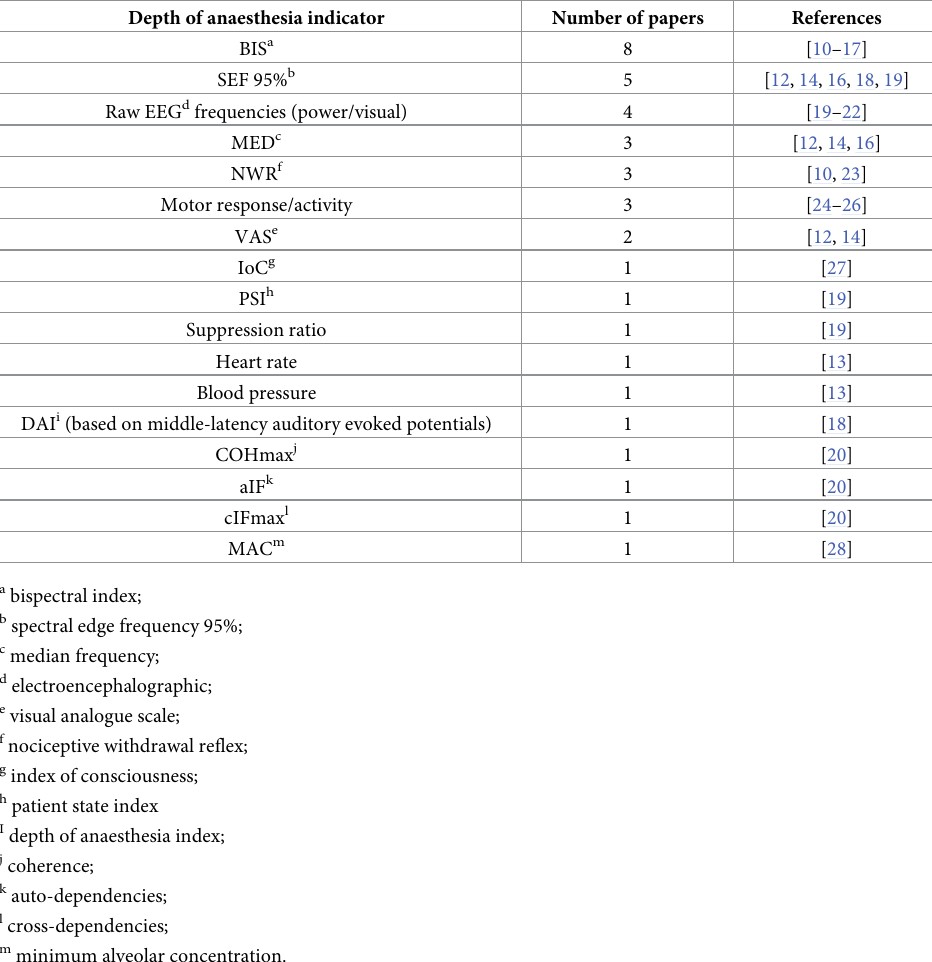
Table 1. Depth-of-anaesthesia indicators included in category